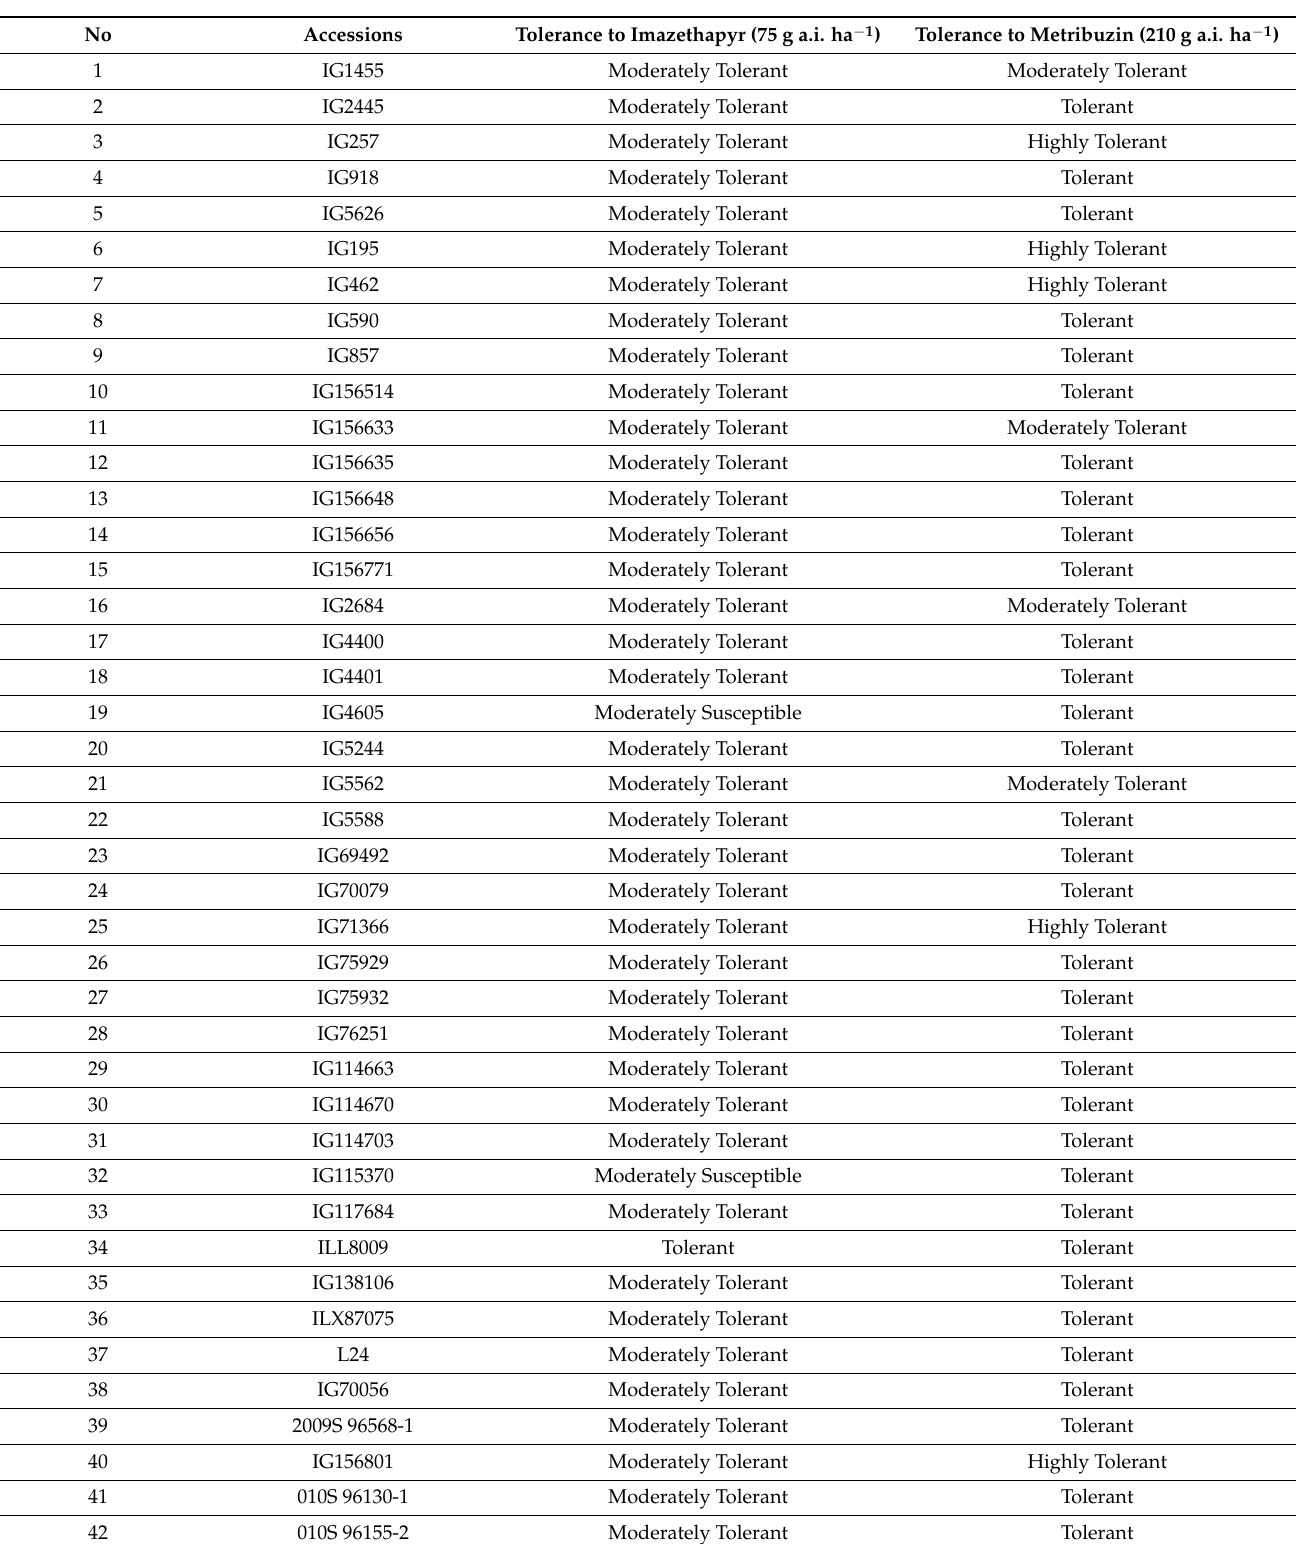
Table 6. List of selected lentil accessions and their tolerance to imazethapyr and metribuzin in validation trials based on a preliminary trial led at Marchouch-2014/15 (unpublished